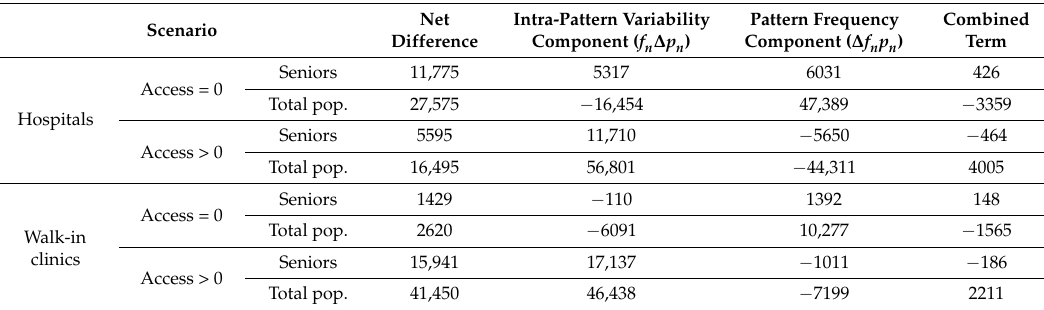
Table 1. Attribution of difference between 2016 and 2022 accessibility patterns. Net difference is difference in population between 2016 and 2022; this difference is decomposed into the intra-pattern variability component, pattern frequency component and combined term. The largest component in each case is highlighted in